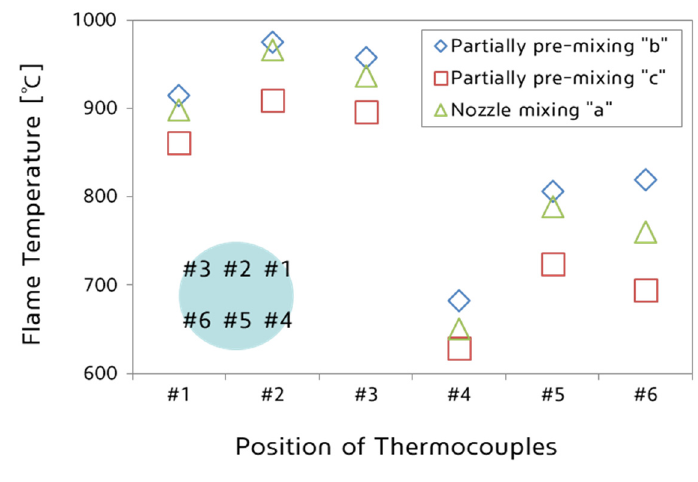
Figure 7. Comparison of the flame temperature ( φ = 1.1, z = 300 mm).